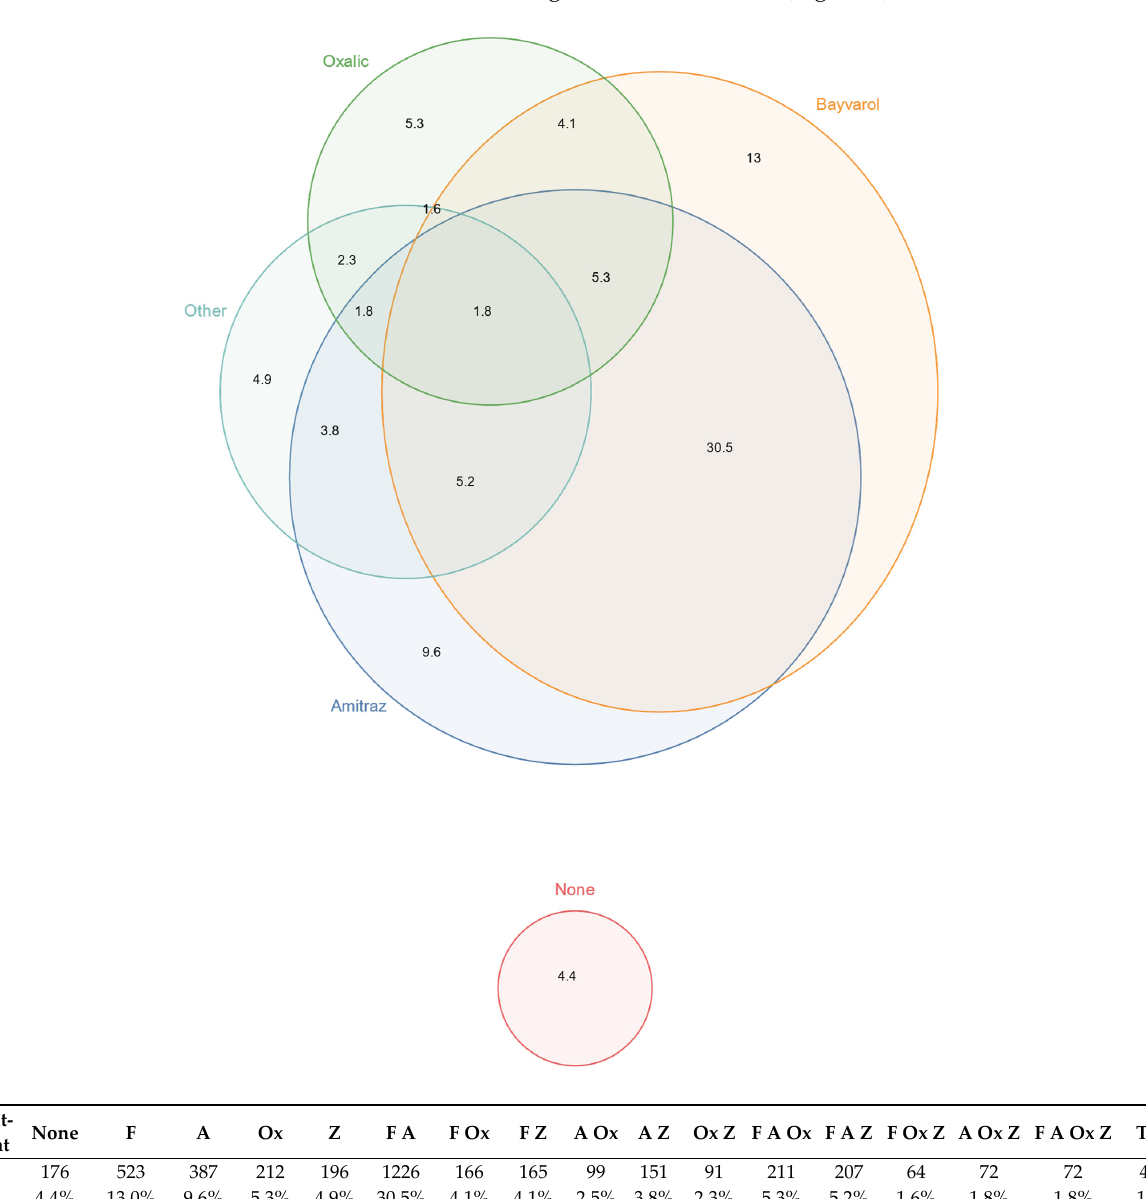
Figure 4. Euler plot showing the percentage of beekeepers using specific treatments between spring 2020 and winter 2021 alongside tabulated figures in the table that show the percentage of beekeepers within each category. F: flumethrin. A: amitraz. Ox: oxalic acid. Z: other treatments.